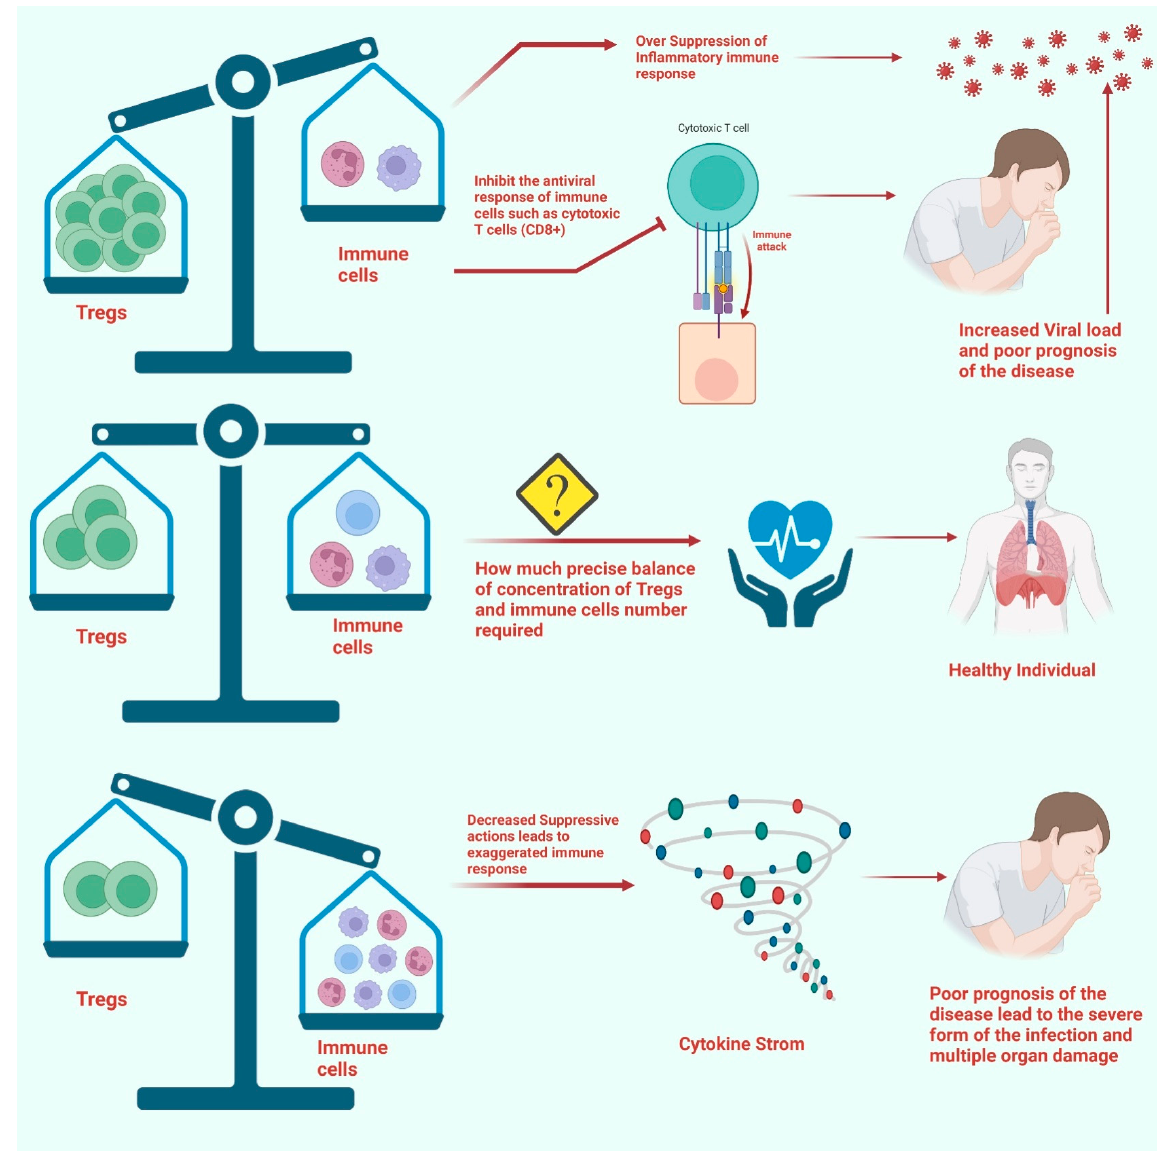
Figure 3. The figure represents the Treg involvement in the pathophysiology of COVID-19. The increased number of Tregs in severely infected patients can play deleterious effects by limiting the antiviral effects of effector T cells. Additionally, the overly expressed FoxP3 in Tregs can lead to excessive immunosuppressive activities, which lead to a poor prognosis of the disease. On the other hand, the substantial decrease in the number of Tregs cannot alleviate the excessively stimulated immune response in severely infected patients. Moreover, a balanced number of Tregs compared to Th1/Th17 T cells and other immune cells can prevent the poor prognosis of the disease. Considering the biphasic functions of Tregs throughout the SARS-CoV-2 infection, it is still debatable how the fraction of Tregs in COVID-19 changed. The number of Tregs has decreased in COVID-19 patients, according to many researchers. For instance, one study found that the Th17/Treg ratio was substantially enhanced while the number of Tregs in ICU-hospitalized patients was reduced significantly [58]. It is interesting to note that the immunomodulatory and immunosuppressive functions of Tregs isolated from severely infected COVID-19 patients were found to be compromised. Another study found a comparable rise in the Th17/Treg ratio in the PBMC of COVID-19 patients, which was associated with a negative outcome and lower levels of TGF-beta and IL-10, cytokines that are important for Tregs